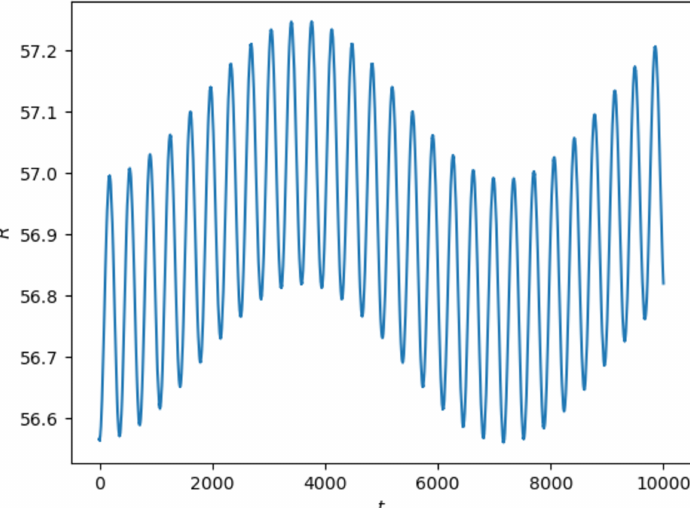
Figure 20 . The evolution of the position of the core of the string along y = z = 0 during 3D dynam- ics. There is no evidence of any growing frequencies of oscillation. There are two main frequency components, a high frequency component which agrees well with the prediction for the zero mode frequency and another unexplained, low frequency oscillation, which we believe to be caused by curvature effects that have induced a small departure from the expected third frequency of f